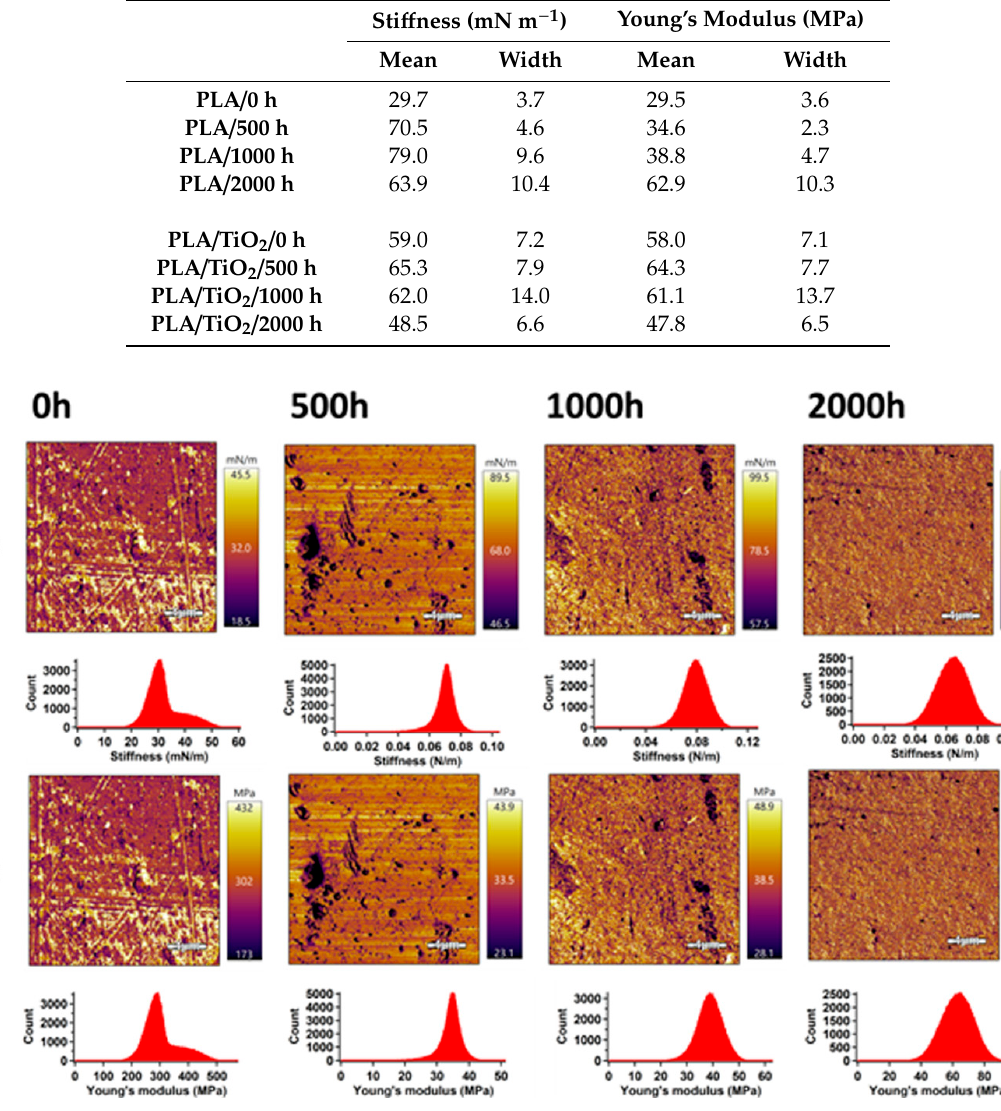
Figure 3. AM–FM images and histograms of PLA samples before and after accelerated weathering; k and E represent stiffness and Young’s modulus, respectively.